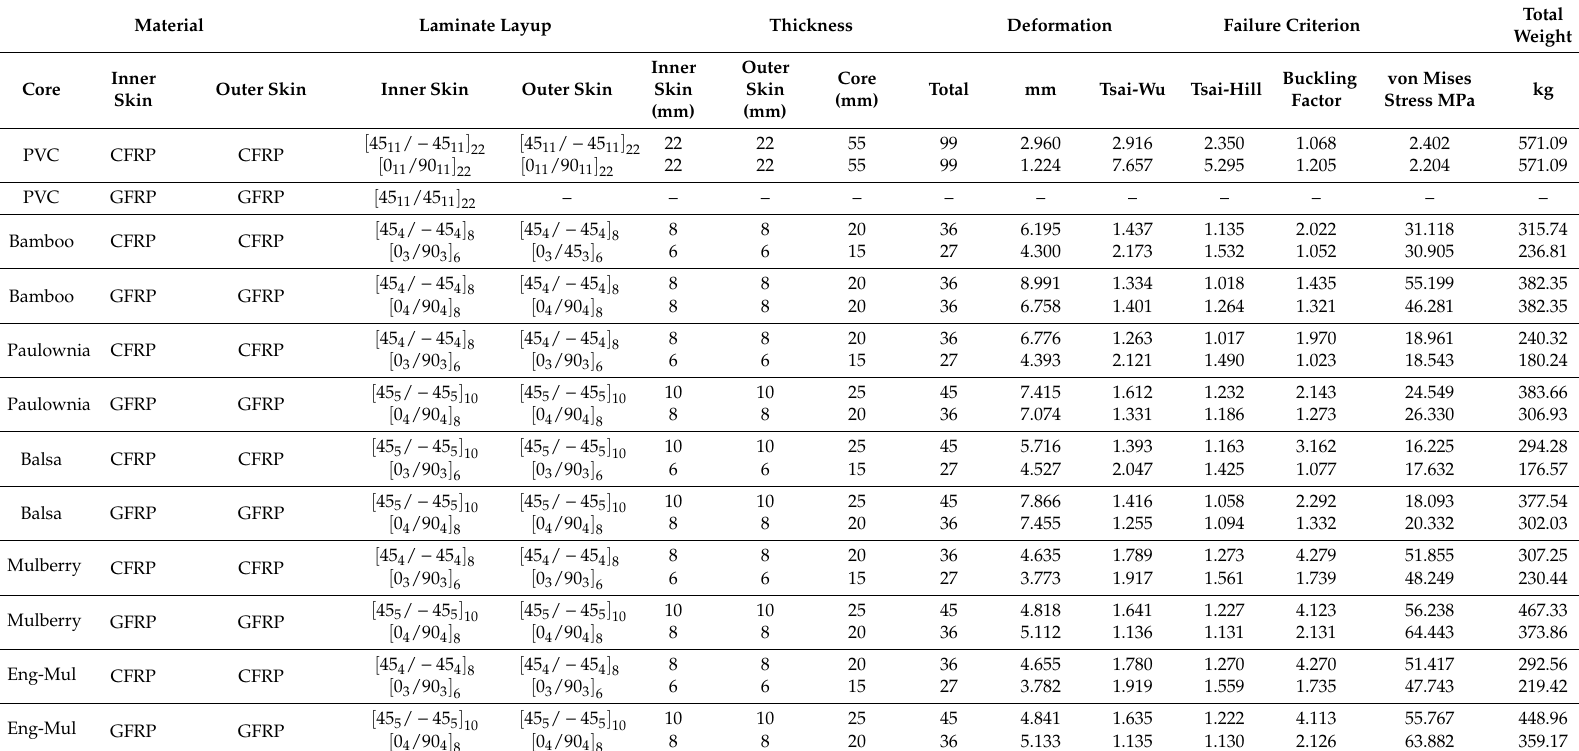
Table 4. Results obtained from ANSYS